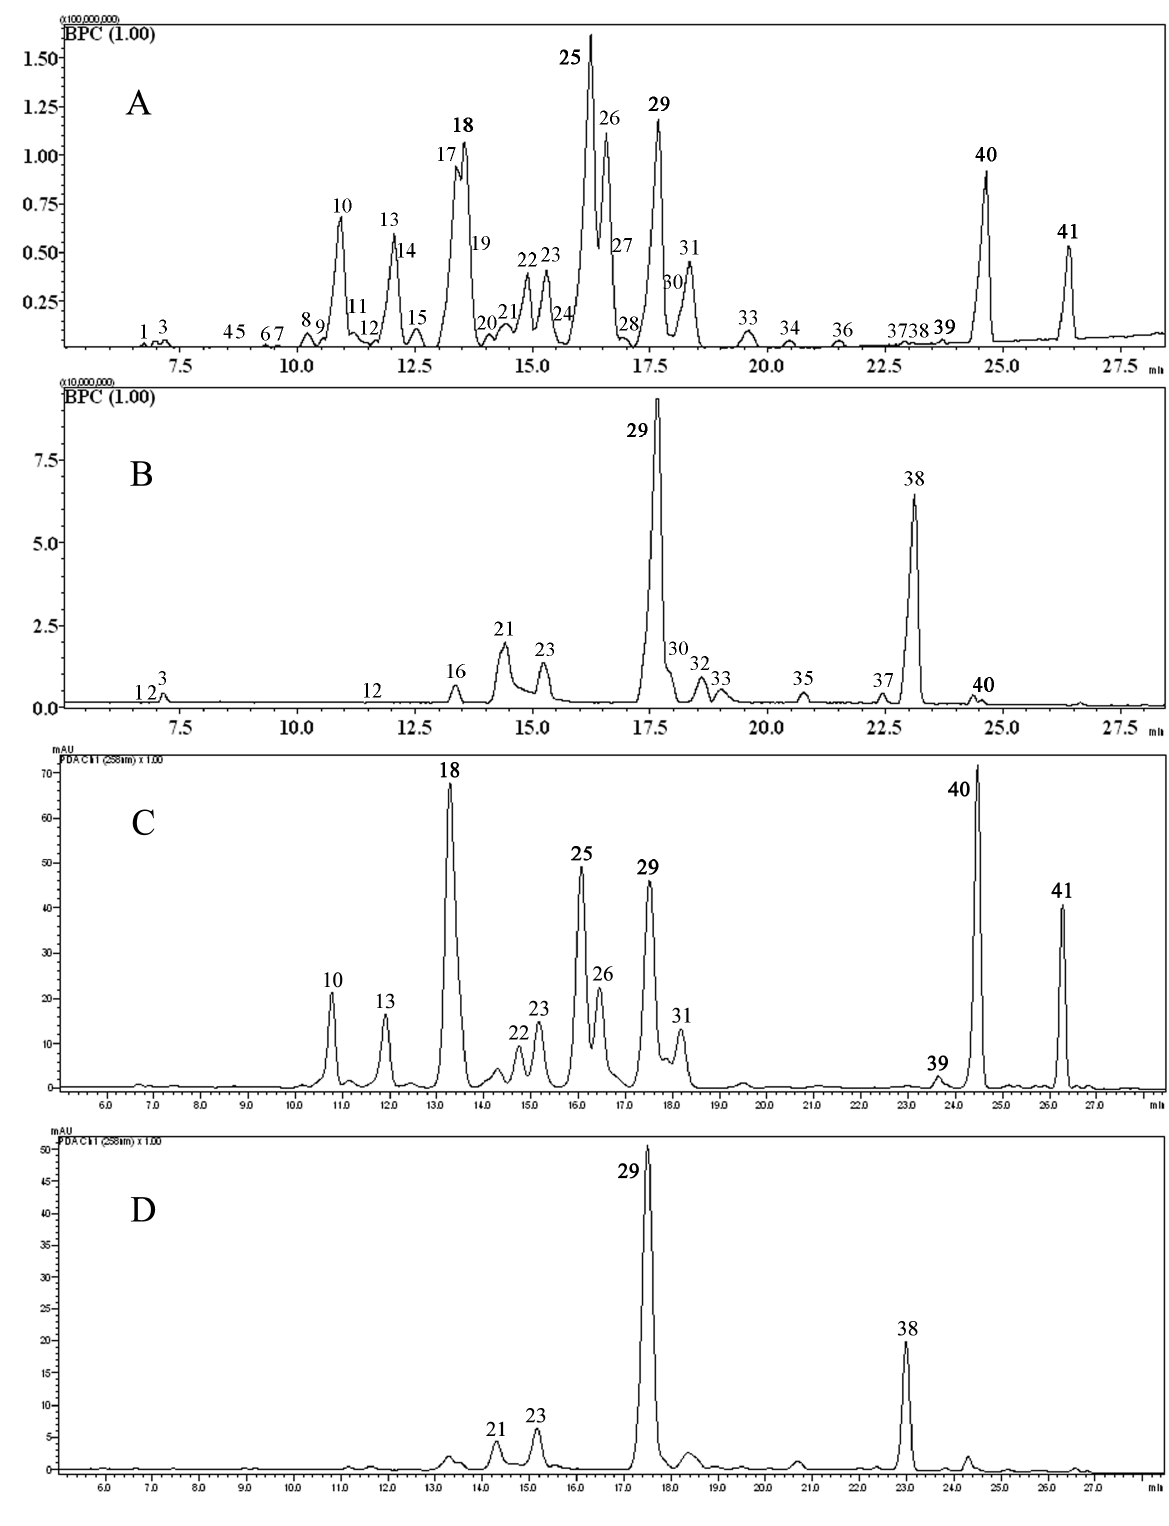
Figure 2. Base peak chromatograms (BPC) of ( A ) Fordiae Cauliflorae Radix and ( B